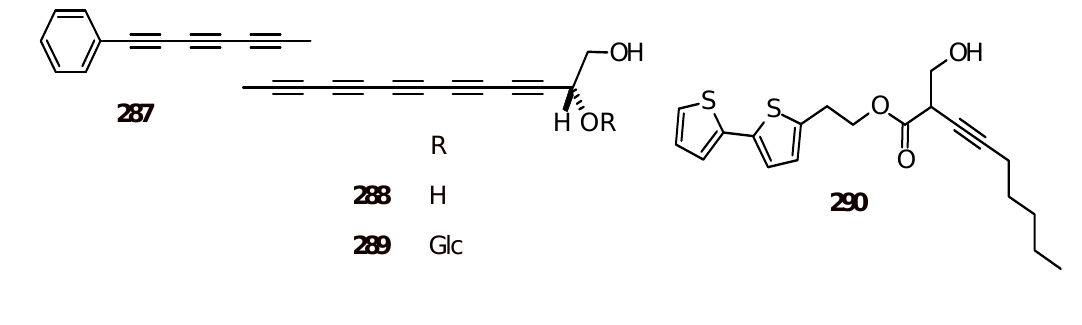
Figure 36. Structures of polyacetylenes 287-290 .